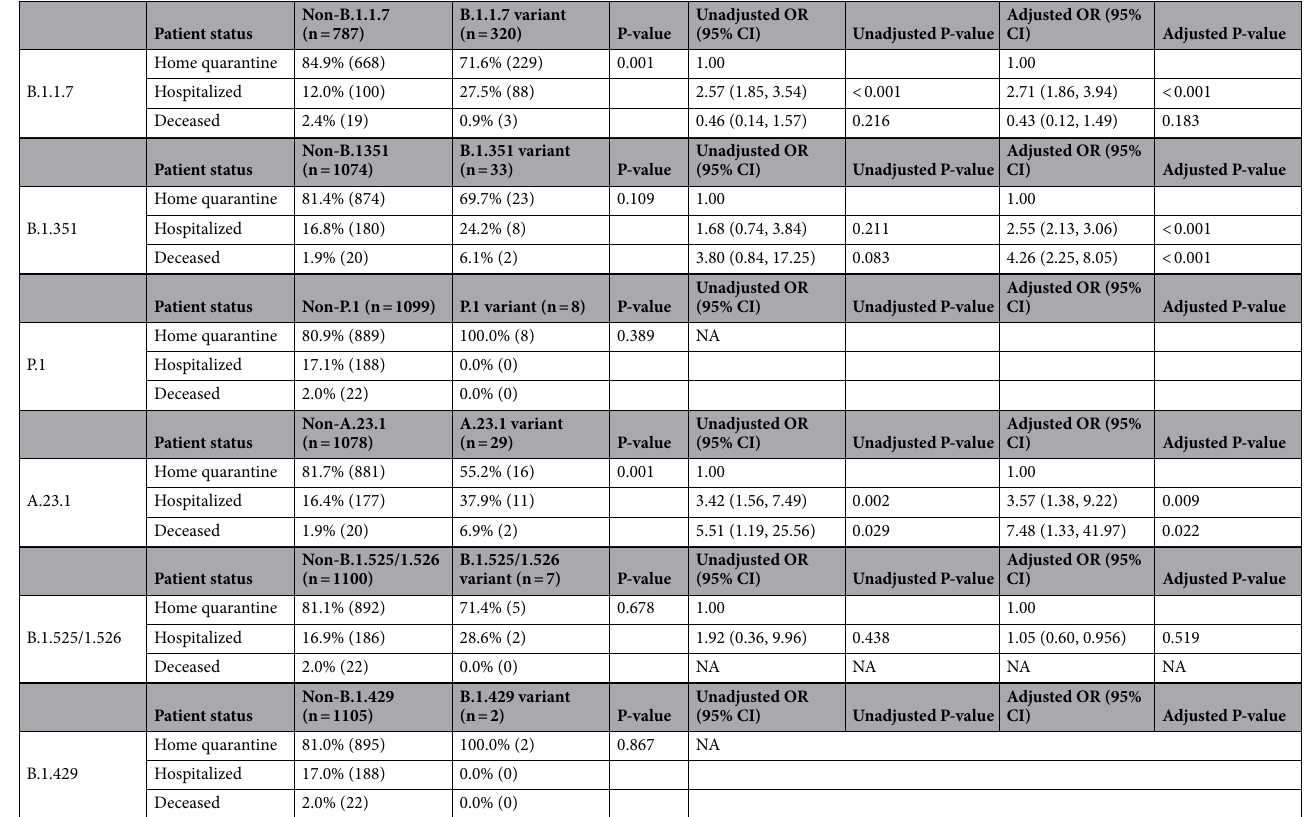
Table 2. Association of SARS-CoV-2 VOC/VOI infections to clinical severity status. Chi-squared test of significance was used to measure associations between reference category (Home Quarantine) and